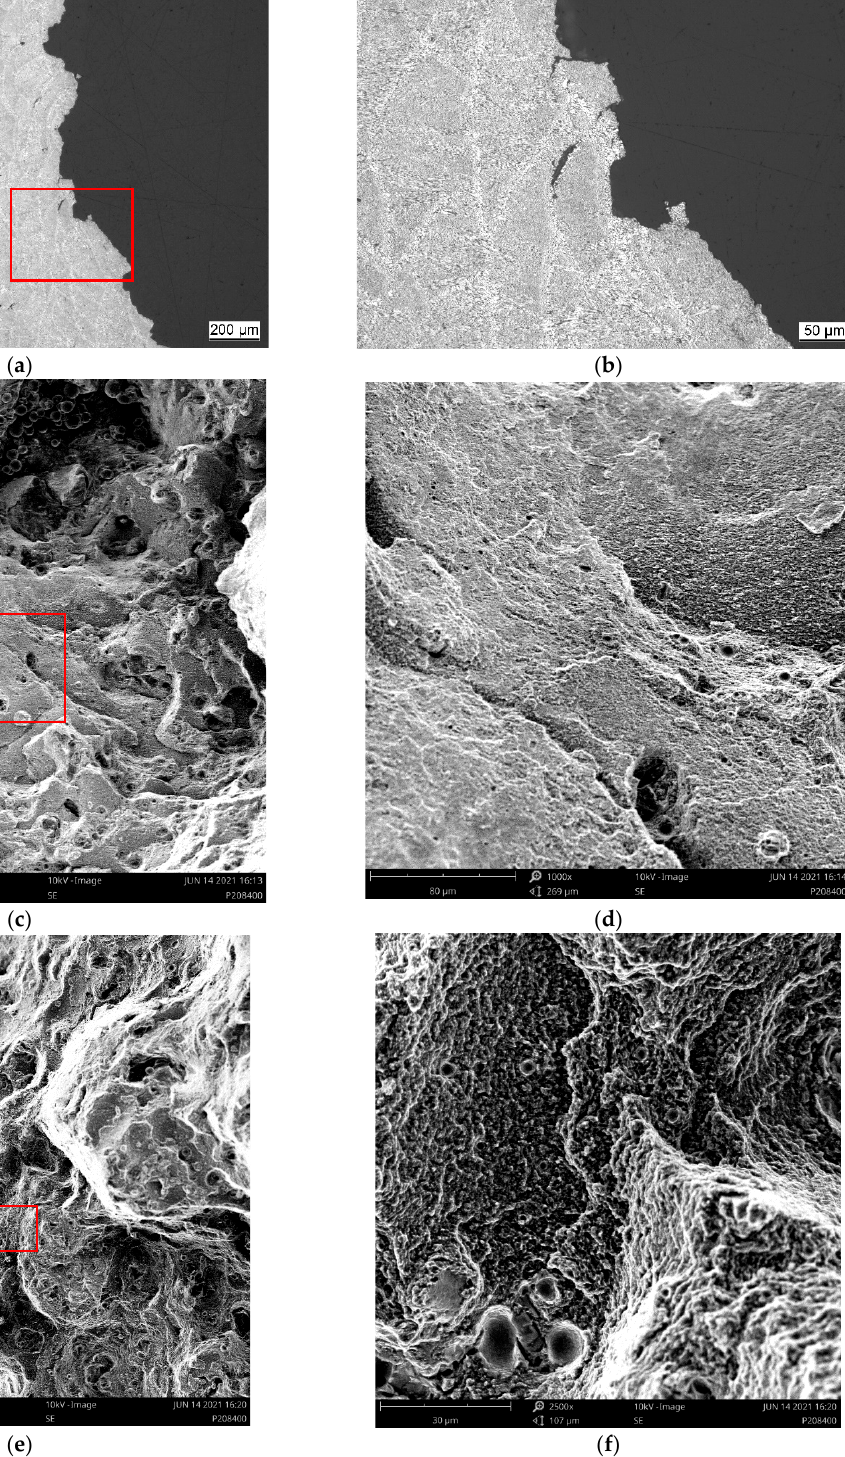
Figure 8. Region of fracture of a sample of polar angle 0° tested at room temperature: ( a , b ) metallo- graphic section of etched samples at different magnifications, ( c , d ) back-scattered electron (BSE) images of the fracture surface at different magnifications and ( e , f ) secondary electron (SE) images of the fracture surface, overview and detailed view. Note that the red box in the image on the left highlights the area depicted in the magnified view on the